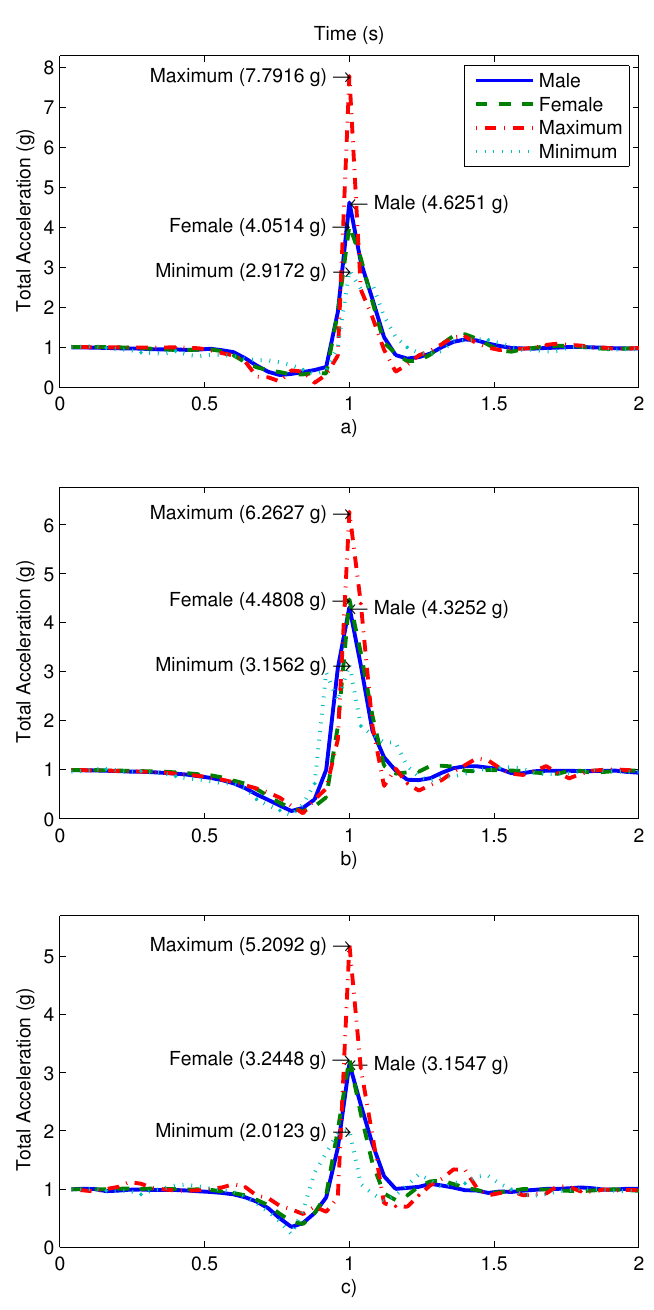
Figure 4. Total acceleration of the waist sensor during the fall actions: ( a ) back sitting; ( b ) back lying; and ( c ) rolling out of bed. The average total acceleration for female/male volunteers and the overall minimum/maximum total acceleration values that occurred during the experiments are